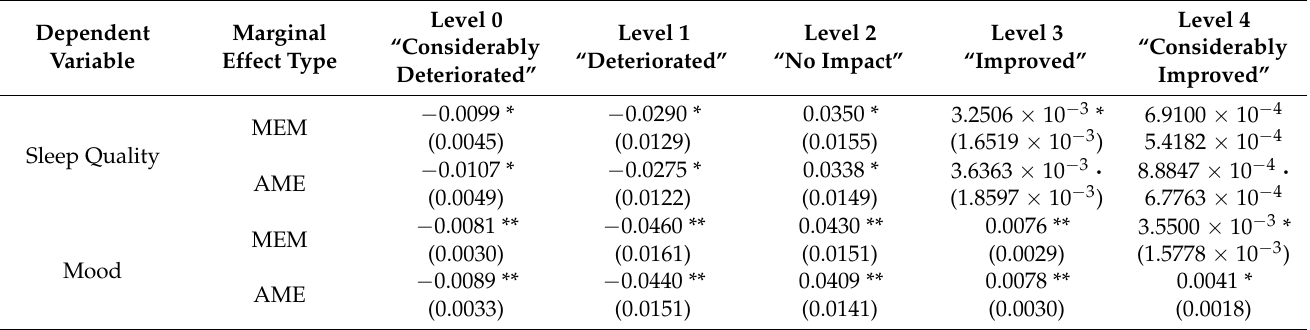
Table 6. Marginal effects of the MAAS scores on